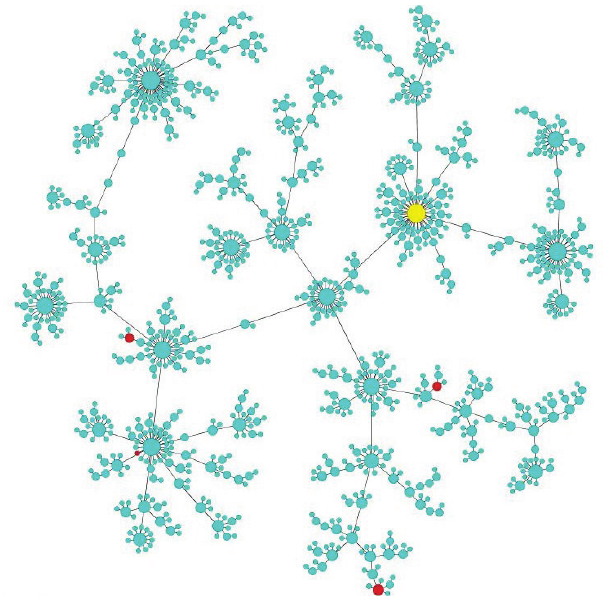
Figure 3: Network structure of online activism. The Save Darfur recruitment network can be divided into 243,916 weak components of members who can directly or indirectly reach each other via social linkages but cannot reach members of other components. Featured is one such component, where edges represent recruitment links, node size is proportionate to the quantity of members recruited, and the original seed recruiter is colored yellow. Of the 1,021 members featured, only 4 (colored red) donated money to the Cause, and the majority (71 percent) recruited no one. the Save Darfur campaign received more than $1 million through direct-mail contributions in fis- cal year 2008 alone (Save Darfur Coalition